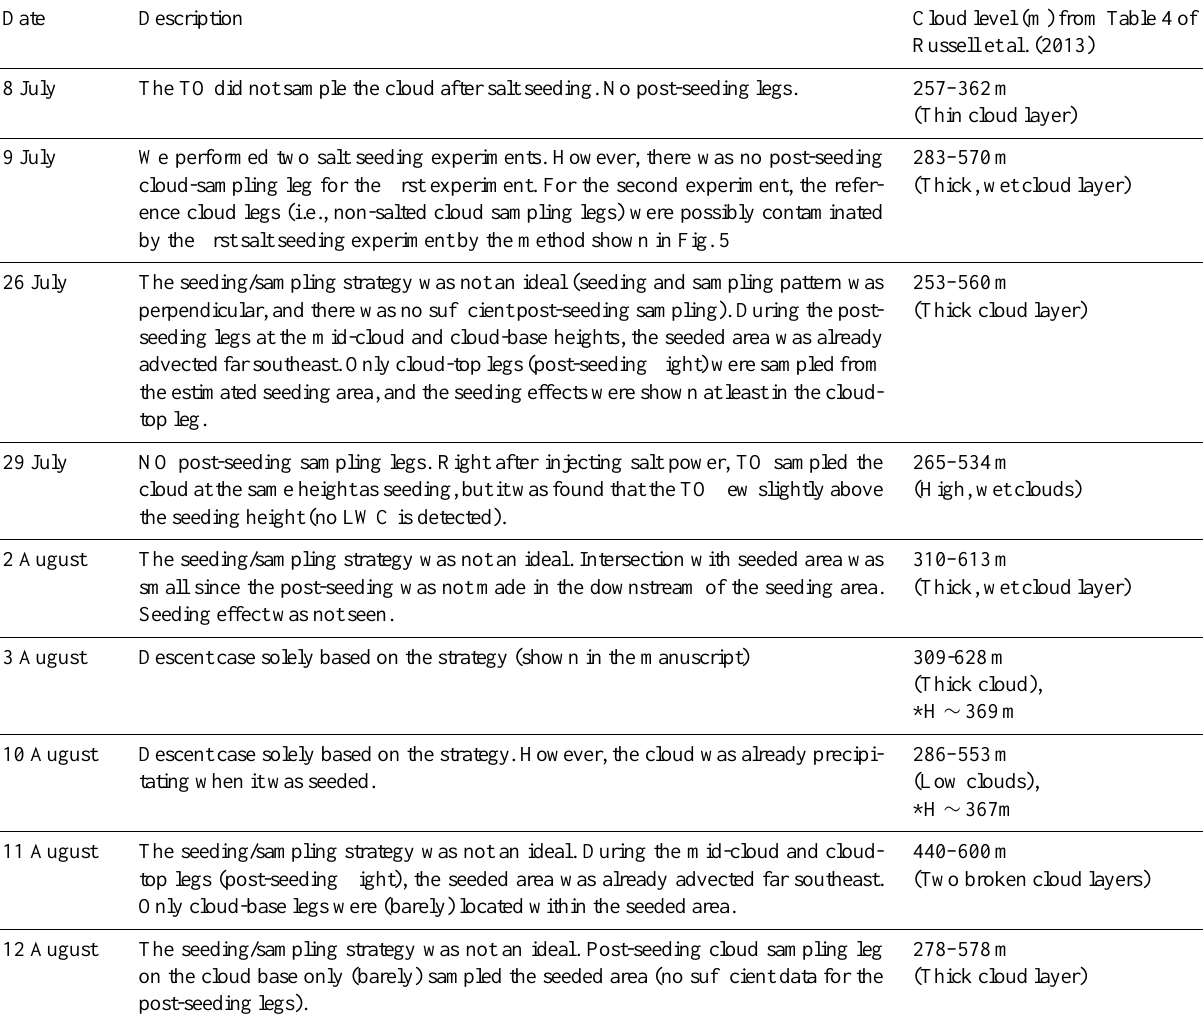
Table A1. Summary of salt seeding